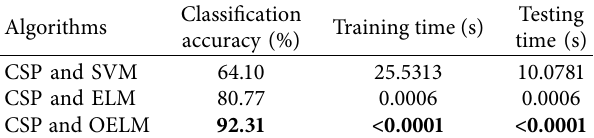
Table 8: Results of different algorithms.